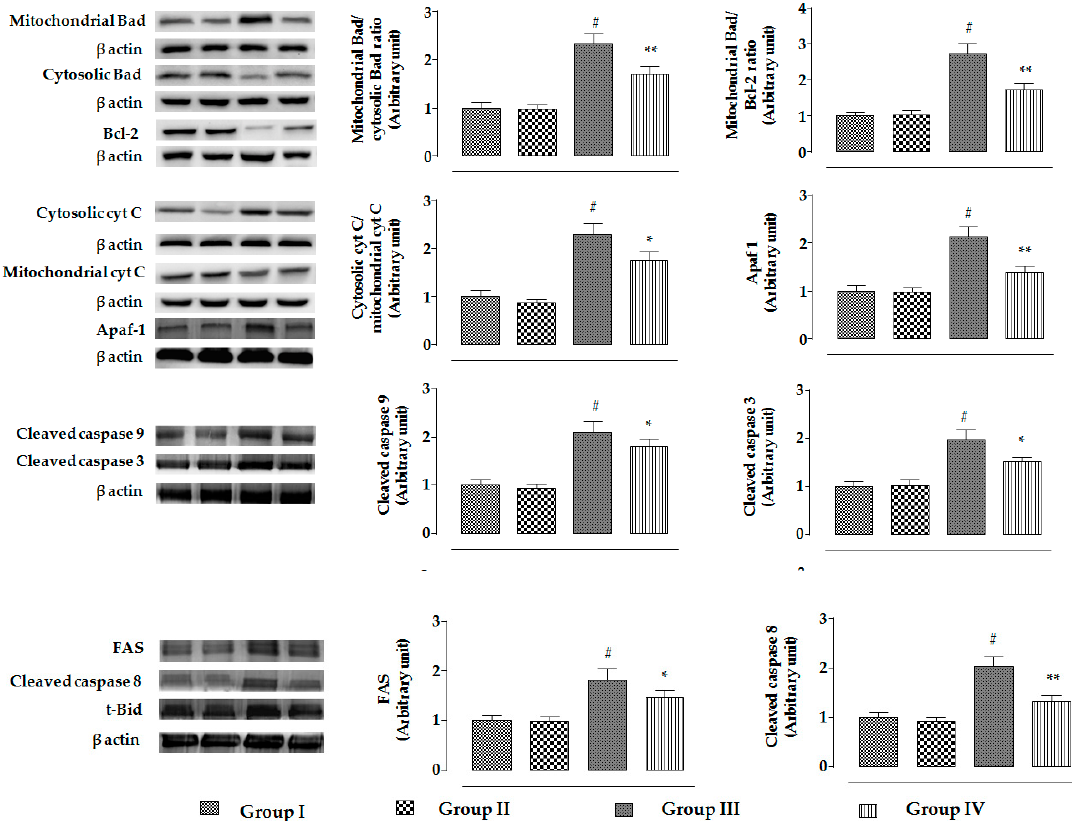
Figure 9. The e ff ects on intrinsic and extrinsic apoptotic signaling in the absence (CdCl 2 ) and presence of RA (CdCl 2 + RA) in vivo on mouse kidneys. The relative band intensities were assessed, and the intensity of the normal control band was assigned as 1. β -Actin served as the loading control. Data are represented as means ± SD, n = 6 (number of plates). # Values significantly ( p < 0.01) di ff er from normal control. * Values significantly ( p < 0.05) di ff er from CdCl 2 control. ** Values significantly ( p < 0.01) di ff er from CdCl 2 control.